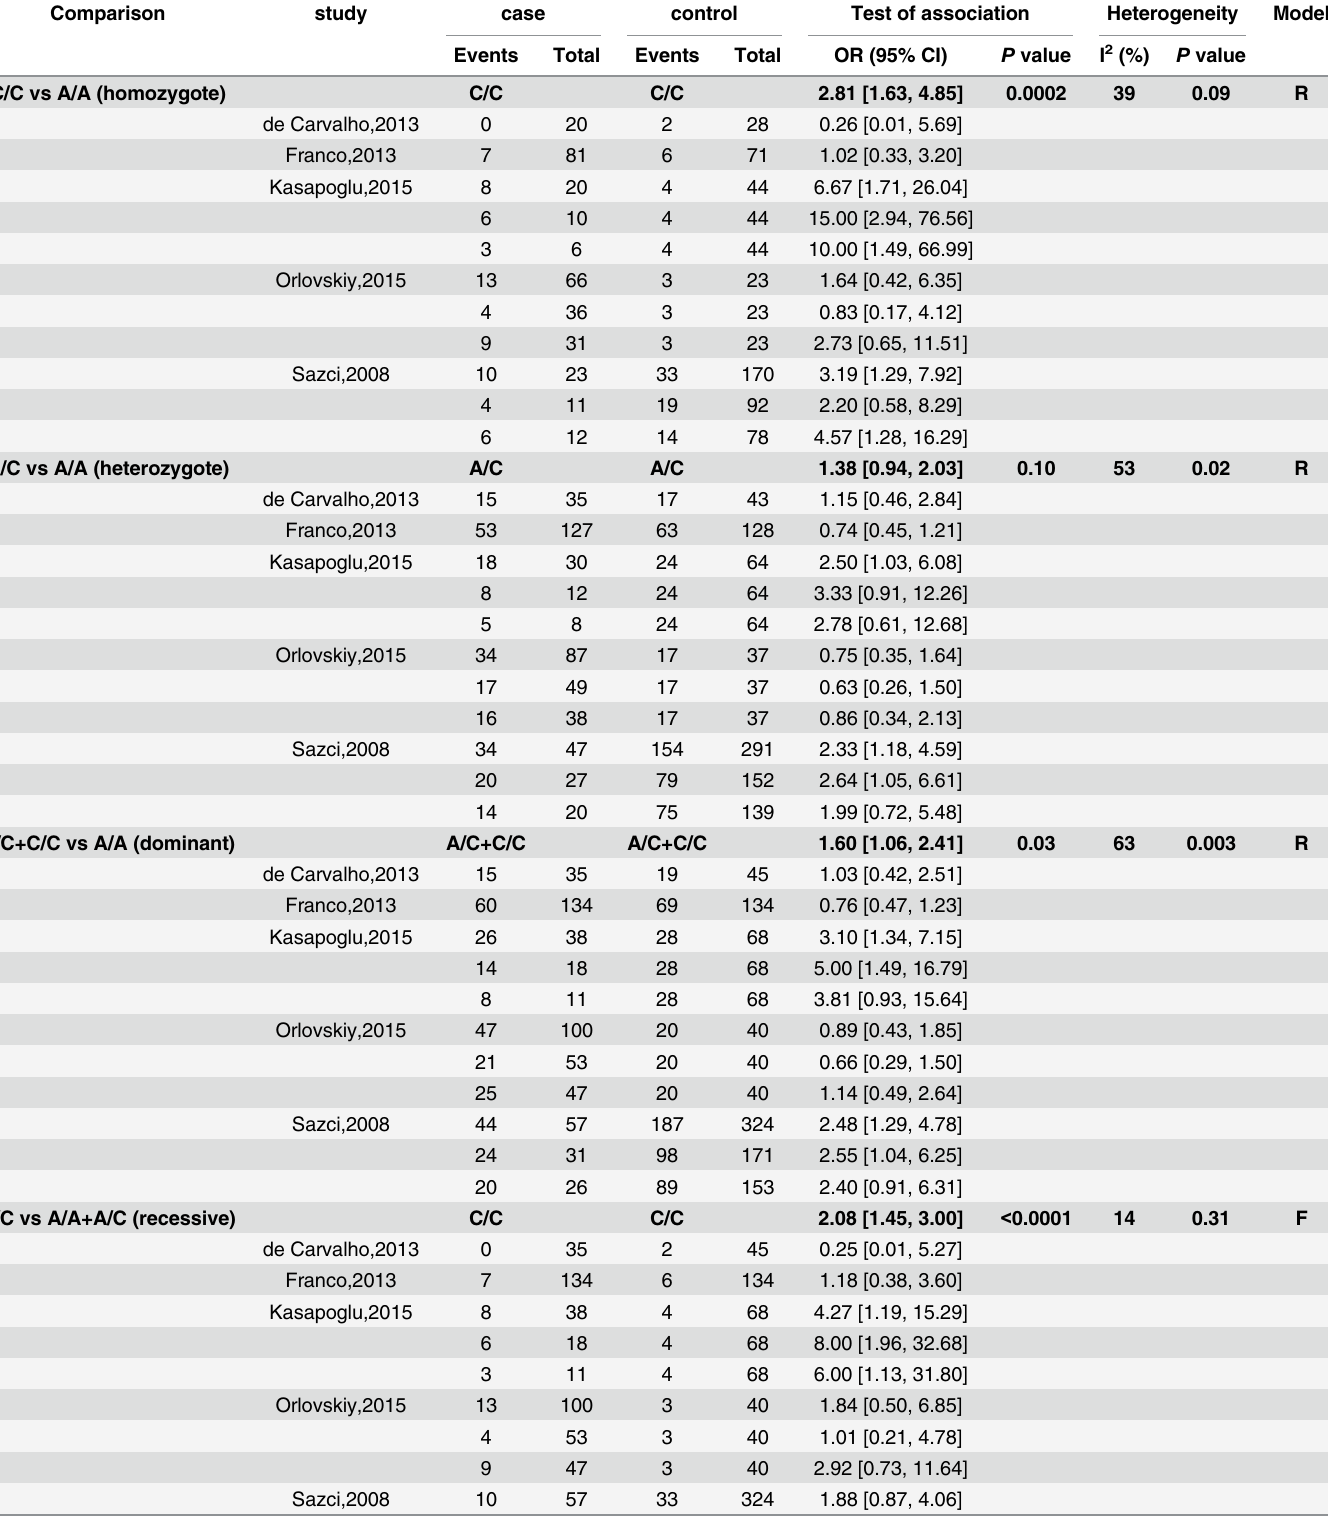
Table 5. Pooled analysis for the association between MTHFR A1298C genotype frequencies and the risks of NAFLD.